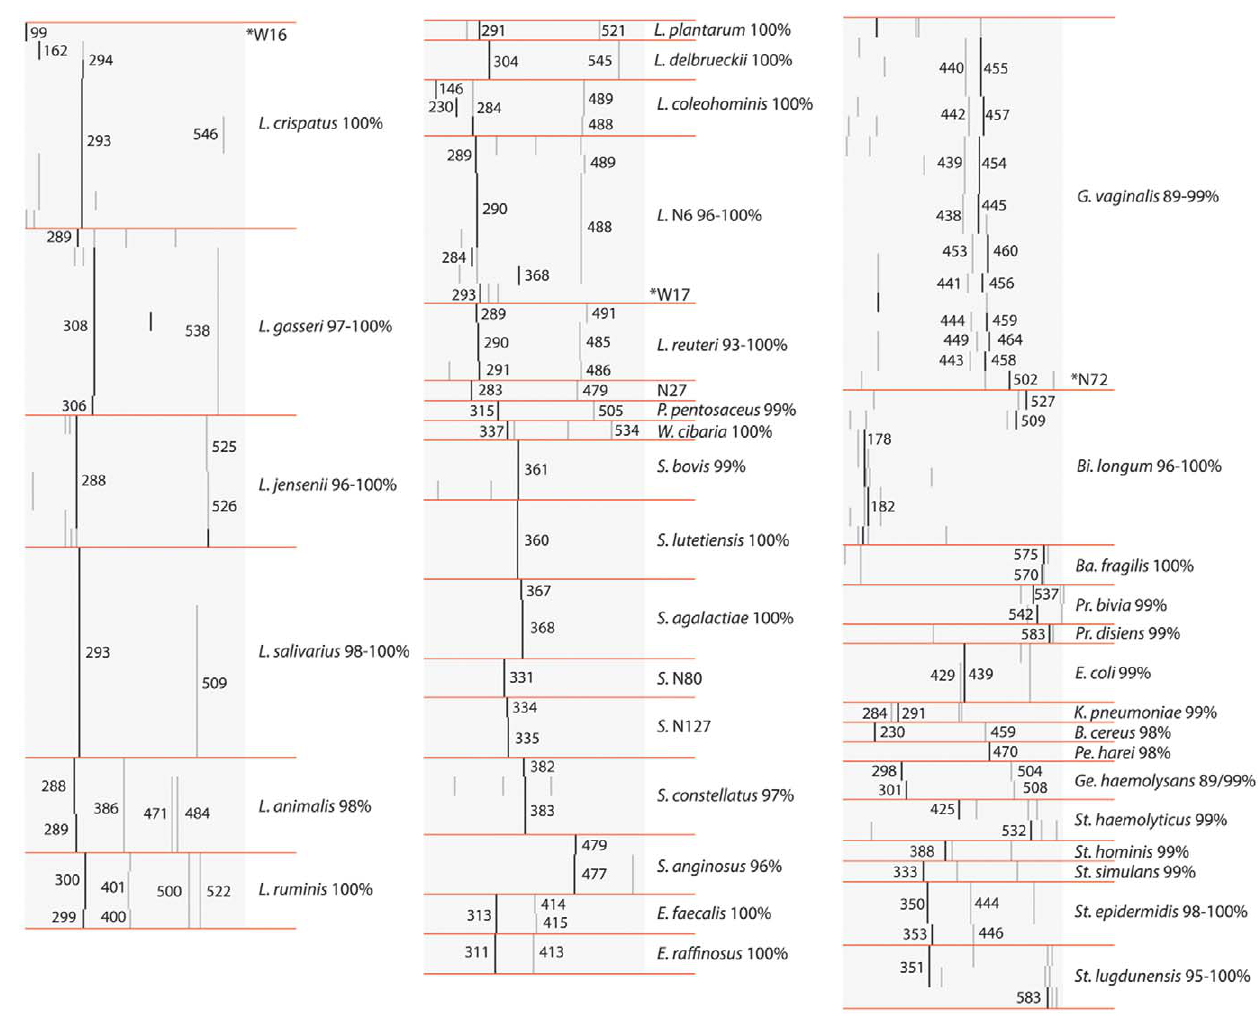
Figure 8. Comparing cpn60 UT sequences and ISR profiles of cultured isolates. Species identification of isolates by cpn 60 UT sequencing is shown alongside ISR profile for each isolate (grey bars), demonstrating correspondence between the two targets. Black bands indicate major peaks and grey bands indicate minor peaks. Image generated using Java TreeView v 1.1.4r3. Abbreviations of genera as in previous figure.